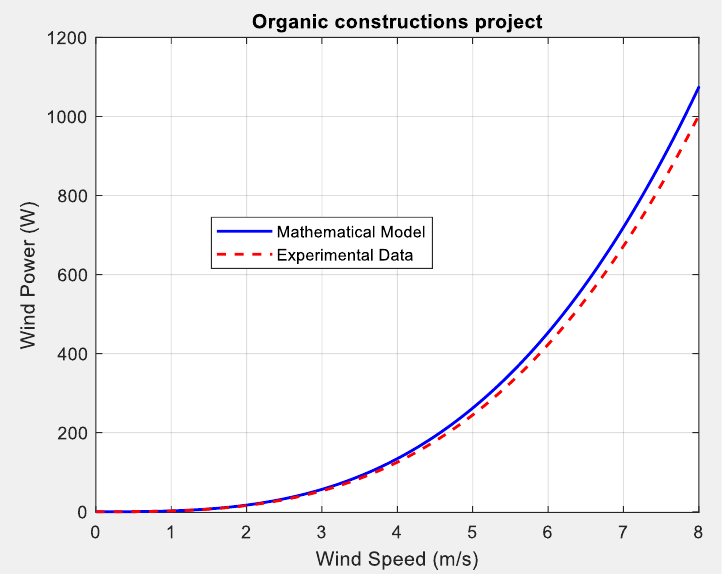
Figure 21. Representative curves of the mathematical model and the experimental curve in a wind turbine.